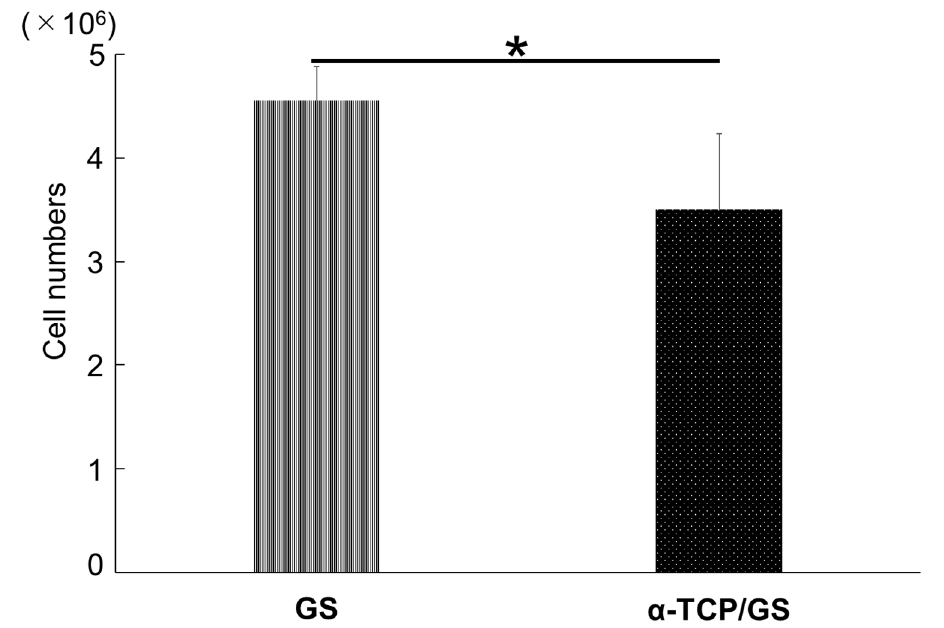
Figure 9. The cell numbers of GS and α -TCP/GS, 24 h after DFAT seeding. Student’s t -test; * p < 0.05; n = 4.